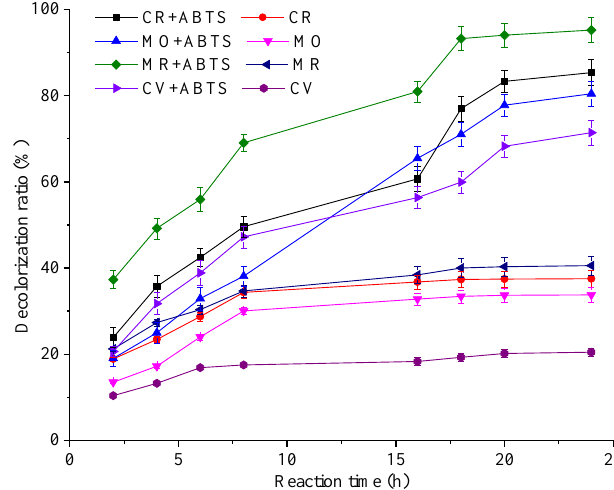
Figure 4. Effects of reaction time on the decolorization of different dyes (CR, MO, MR, CV) in laccase or an ABTS-laccase mediated system. Data were expressed as mean ± SD (n = 3).